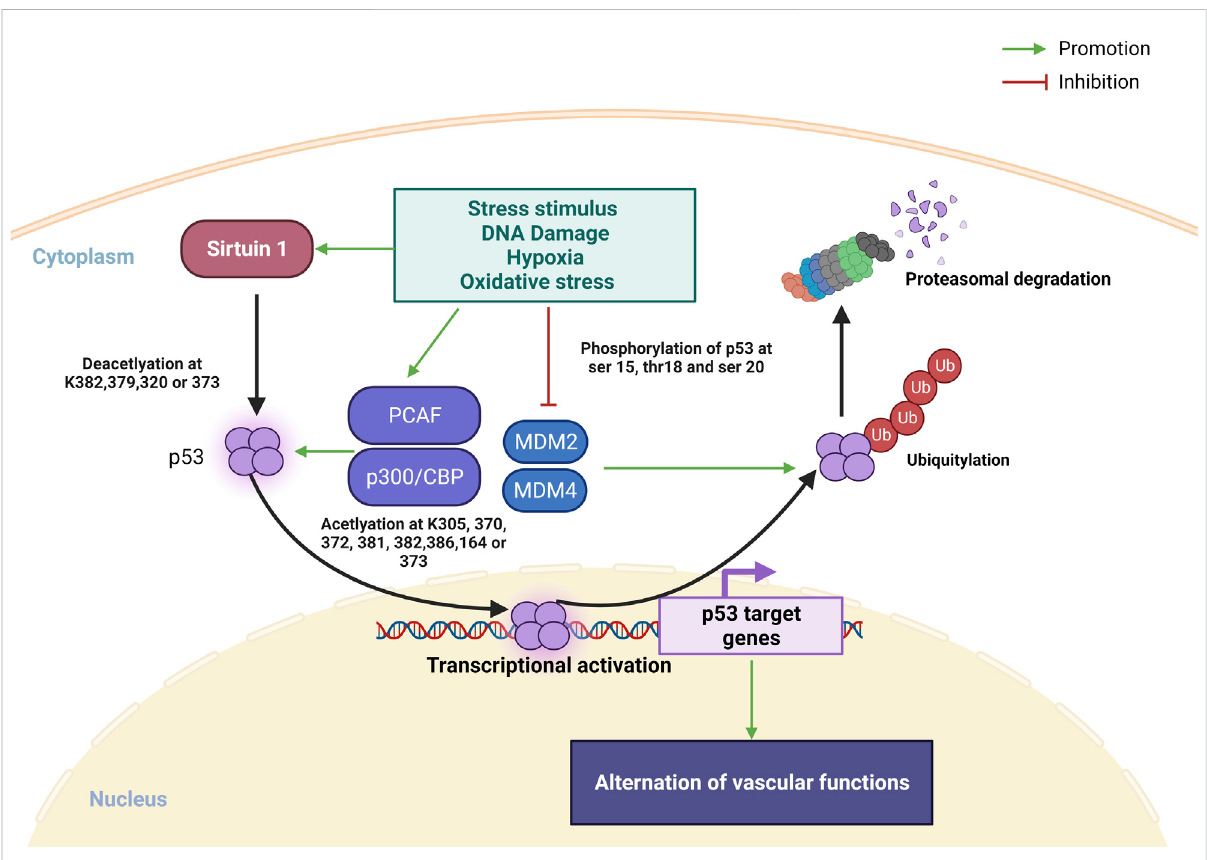
FIGURE 1 Overview on posttranslational modi fi cations of p53 under stress stimulus. In normal condition, MDM2 and MDM4 promotes p53 ubiquitination leading to p53 degradation in proteasome. Under stress stimulus, sirtuin 1 is activated and deacetylate p53 at K382, 379, 320 or 373 for promoting p53 transcription, PACF and p300/CBP is also activated to promote p53 transcription via acetylation at k305, 370, 372, 373, 381, 282, 386 or 164. Ubiquitin proteasome of p53 degradation is inhibited via repression MDM2 and MDM4 binding to p53 by stress stimulated phosphorylation of p53 at ser 15, 20, and thr18 (Created with